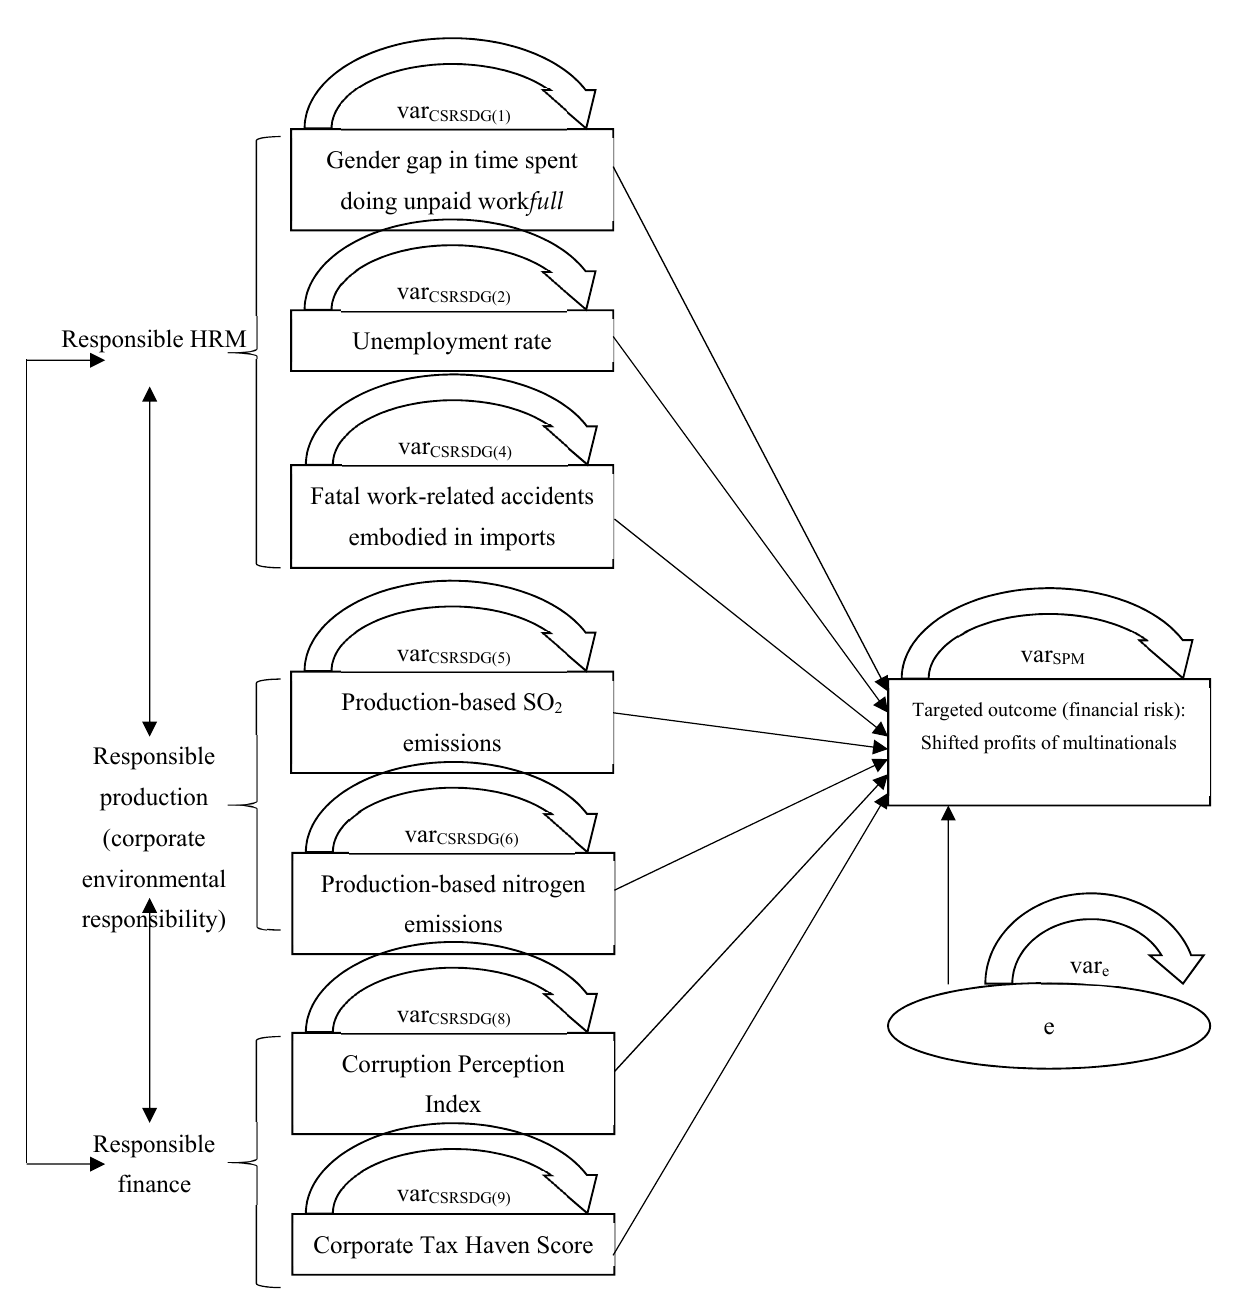
Figure 2. The generalised block diagram of the structural equation model. Source: authors.